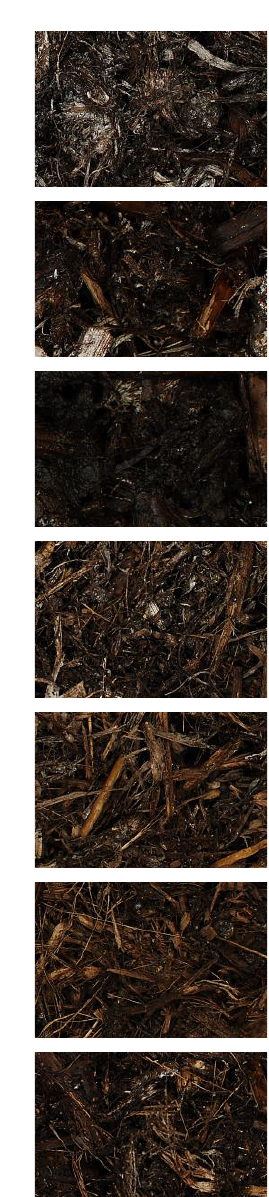
Figure 1. The photographic chambers used in the study.